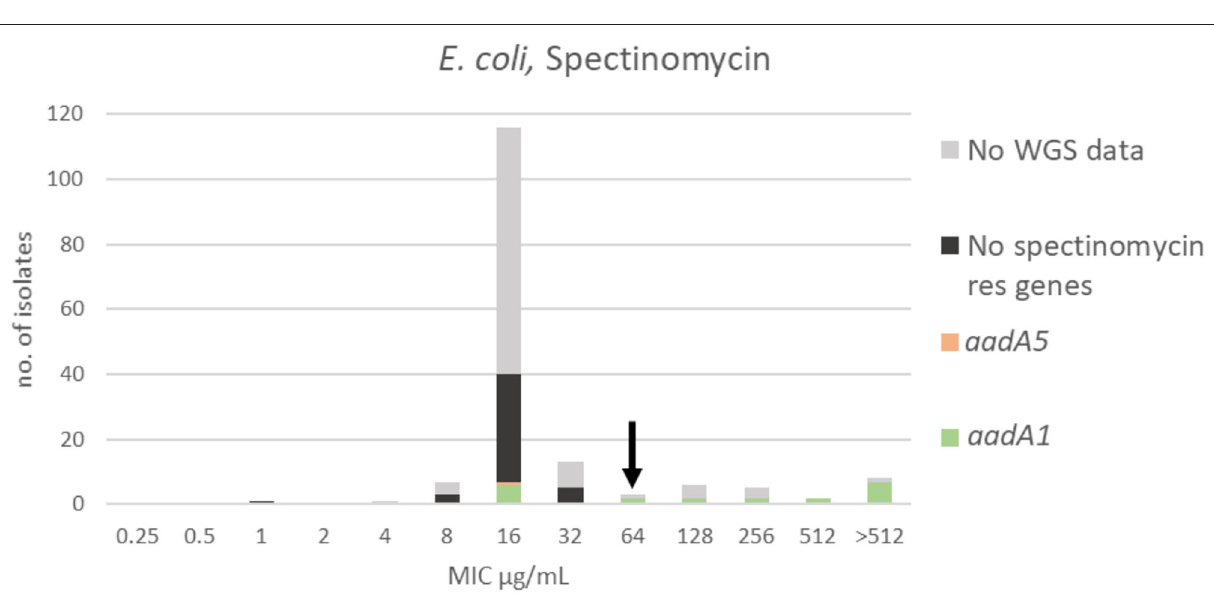
FIGURE 4 | MIC distribution of E. coli ( n = 162) against spectinomycin in the test range of 0.25–512 µ g/mL. The arrow indicates the epidemiological cut-off value (ECOFF, EUCAST). Colors indicate if the isolates have been sequenced and whether they harbor known relevant resistance genes. WGS, whole-genome sequencing; res,